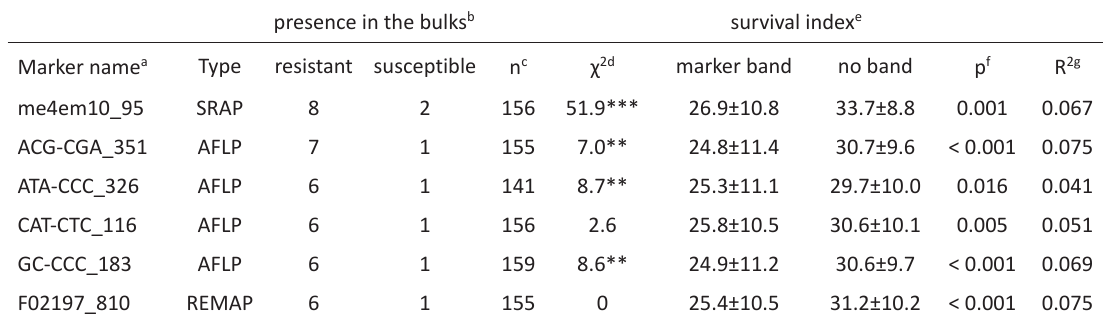
Table 1. Putative markers associated with speckled snow mold resistance in the F Nosappu. Associations were analyzed with regression